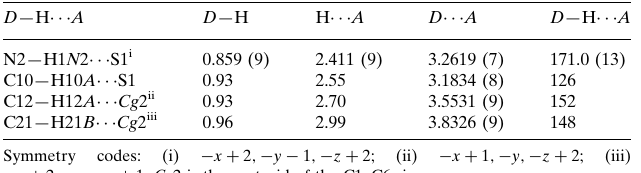
Hydrogen-bond geometry (A˚ , (cid:1)